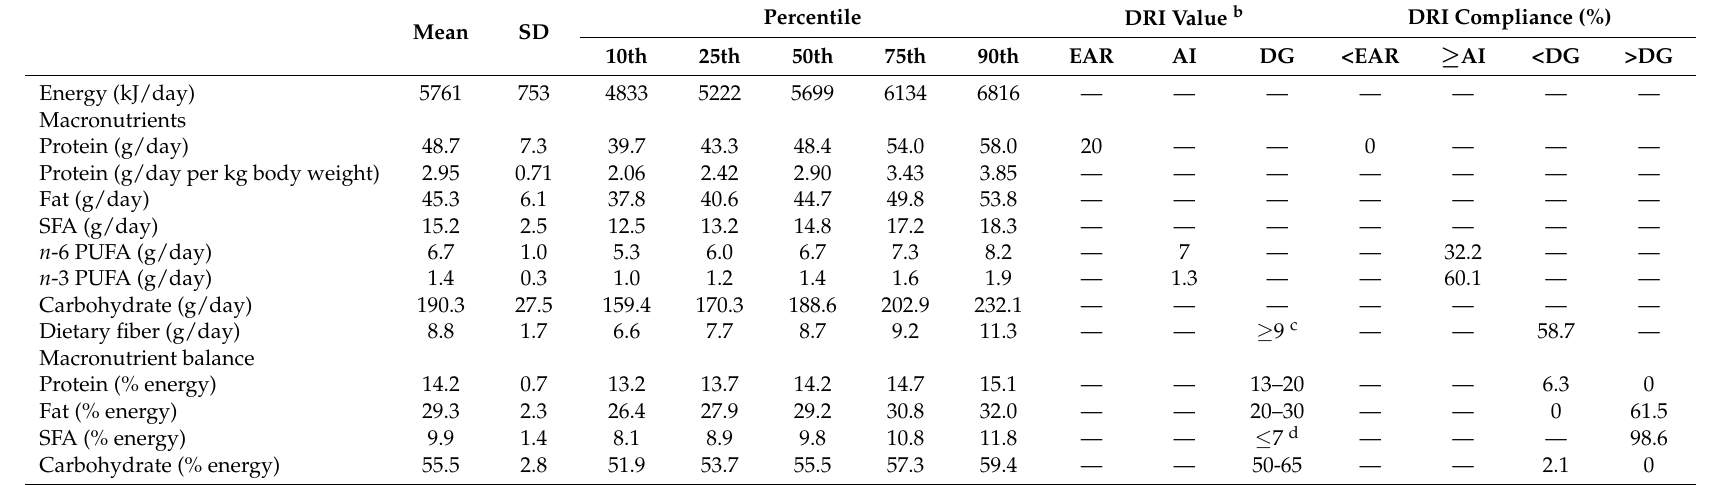
Table 2. Usual intakes of energy and macronutrients from foods and beverages for Japanese boys aged 3–5 years ( n = 143) a